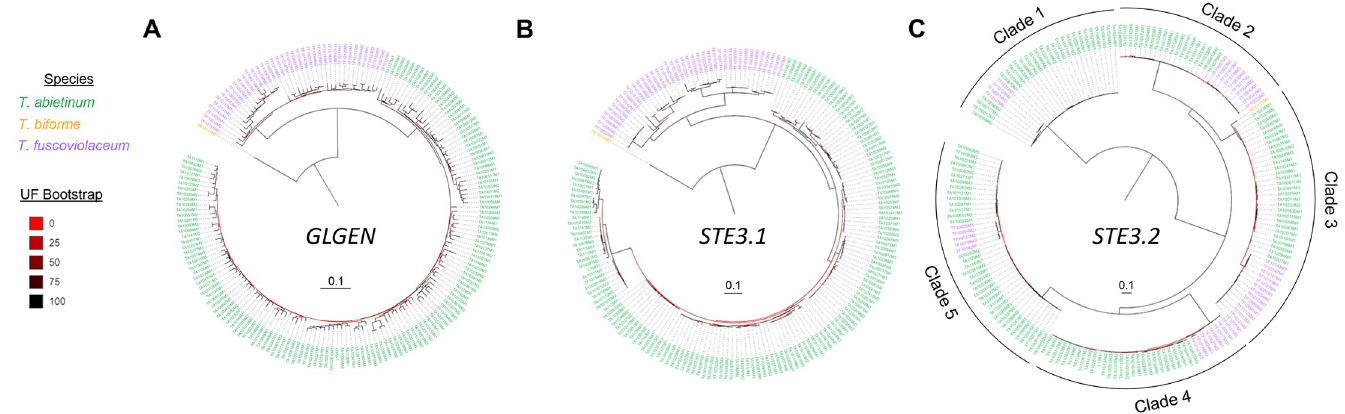
Fig 7. ML phylogenetic tree topology of mating proteins suggests balancing selection and trans-species polymorphisms. ML phylogenetic protein trees of GLGEN (a flanking gene), STE3 . 1 (a potential non-mating pheromone receptor protein) and STE3 . 2 (a mating pheromone receptor protein) are represented in panel A, B and C, respectively. Strains were colored according to the species designations as indicated in the legend. Branch support was assessed using the ultrafast bootstrap (UF bootstrap) method. UF bootstrap is indicated in each branch by a gradient color according to the legend. Scale bar is represented in number of amino acid substitutions per site. The rest of phylogenetic protein trees and more detailed trees for the represented here are found in S5 Fig.